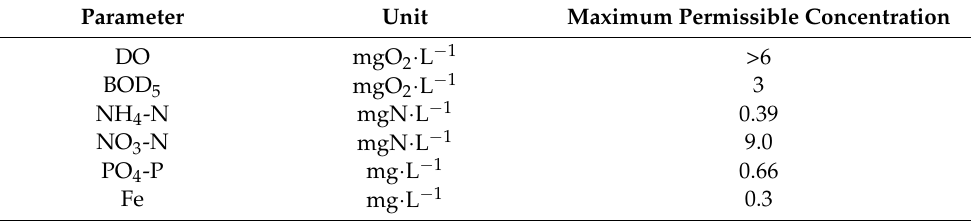
Table 2. Maximum permissible concentration of each parameter as regulated by hygienic norms, specifically HN 2.15.1315-03